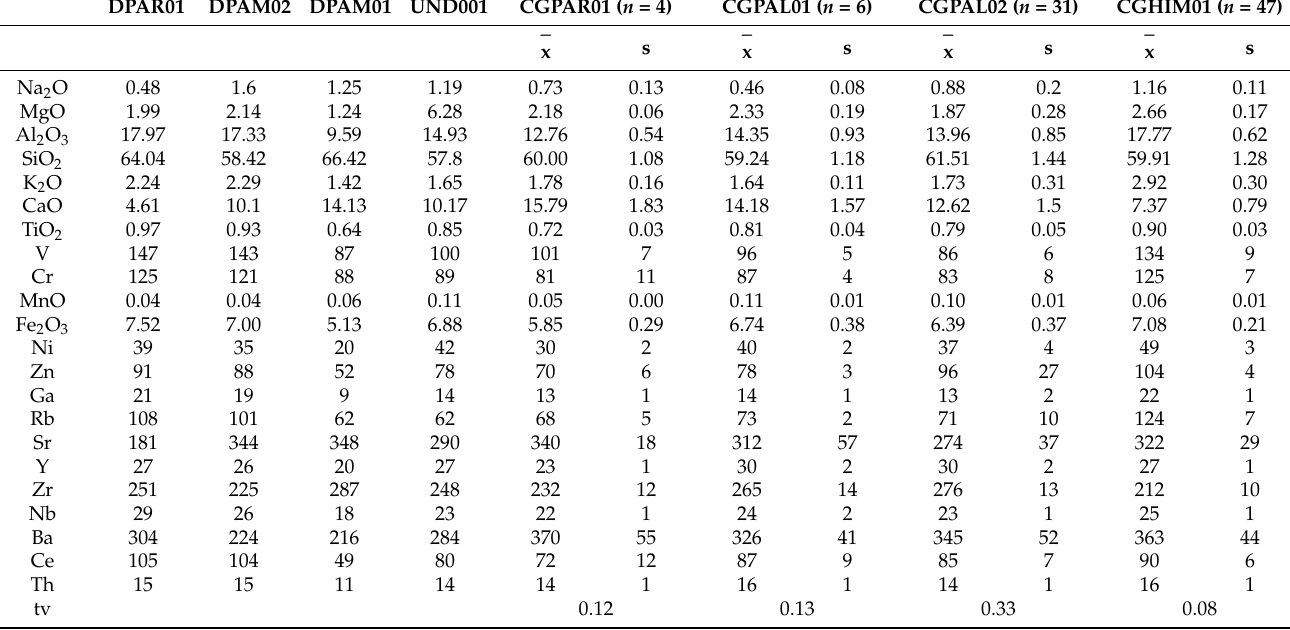
Table 3. Mean (x), standard deviation (s), and total variation (tv) of the groups of more than two samples and values of the loners (as normalised values). Major and minor elements (expressed as oxides) in w %. Trace elements in µ